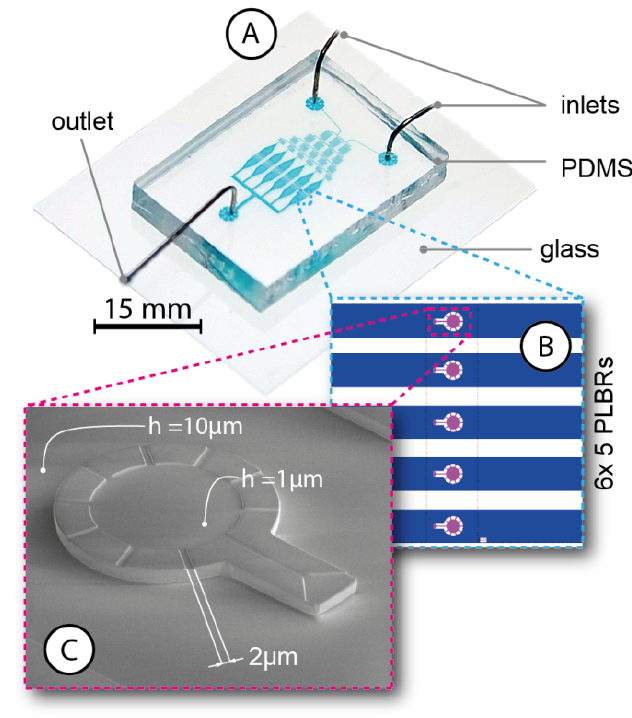
Figure 4: Microfluidic chip device with picolitre bioreactors for single cell cultivation.